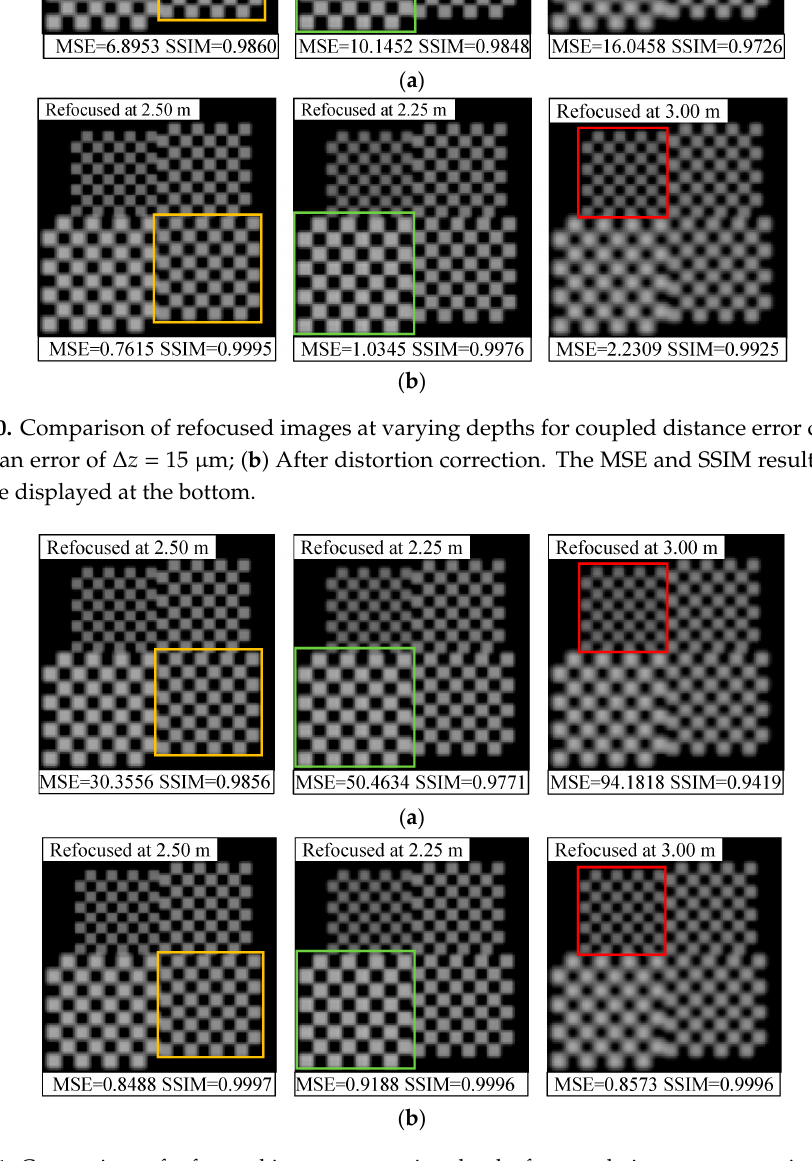
Figure 11. Comparison of refocused images at varying depths for translation error correction: ( a ) With an error of Δ t = 15 μ m at φ = 90 °; ( b ) After distortion correction. The MSE and SSIM results for each image are displayed at the bottom.